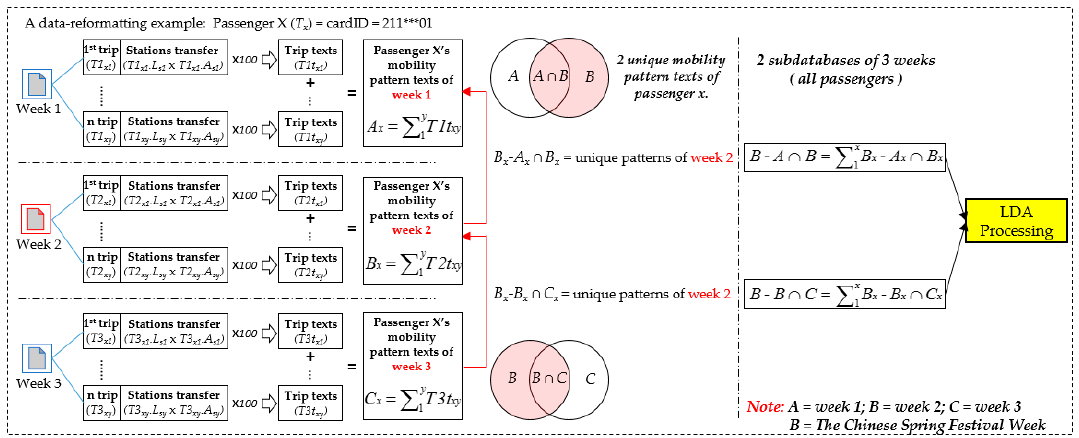
Figure 7. Process of reformatting the mobility pattern datasets.